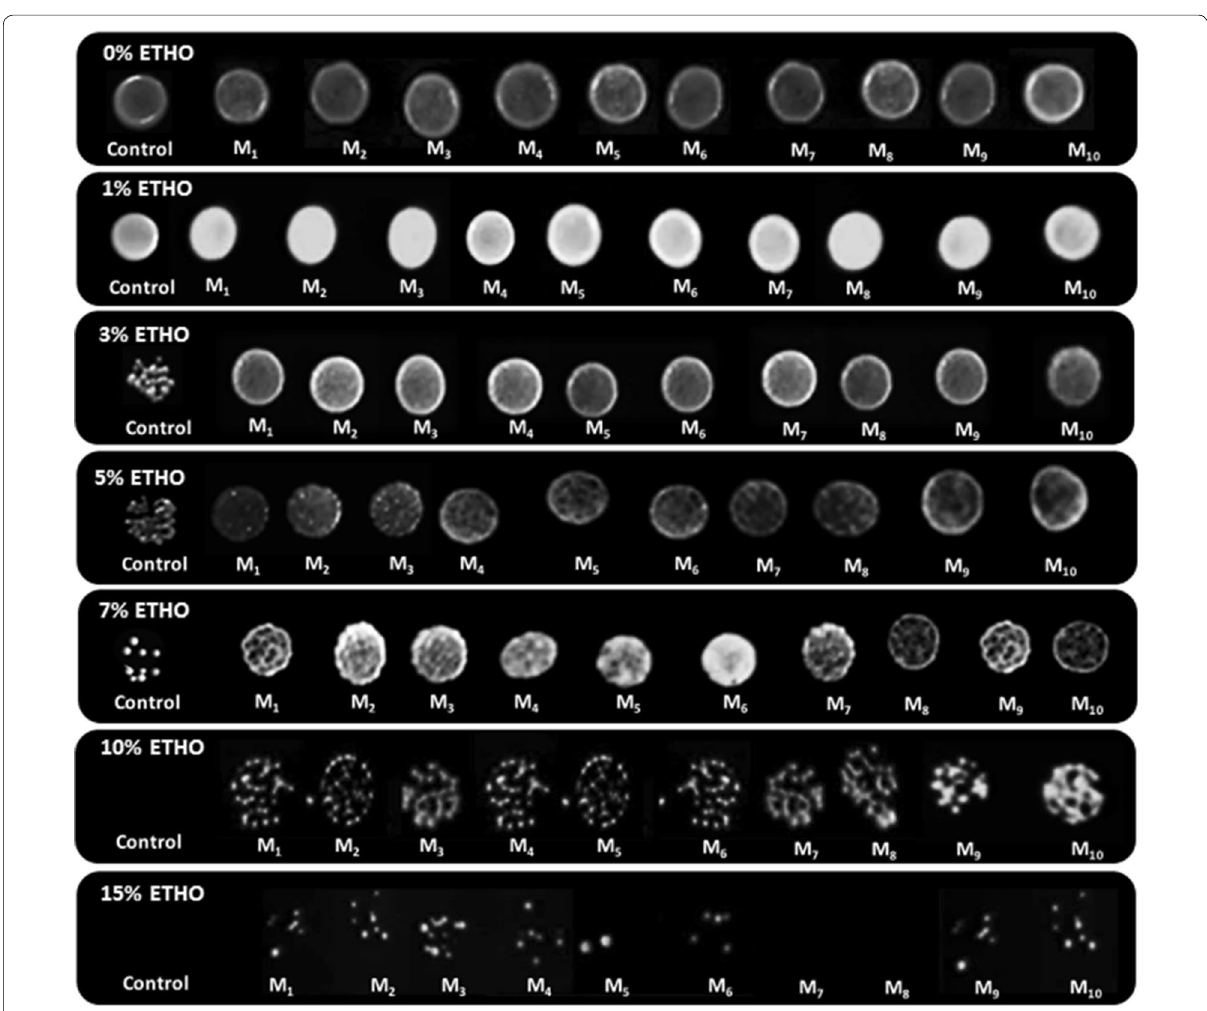
Fig. 3 Susceptibility of ethanol tolerance of S. cerevisiae mutant strains with various levels of ethanol concentrations (0, 1, 3, 5, 7, 10 and 15%) on YPD media containing Kan. M1, M2, M3, M4, M5, M6, M7, M8, M9 and M10 refer to the numbering of mutations colonies; as follows: R‑M20C1‑P3, R‑M16C4‑P3, R‑M4C1‑P3, R‑M12C4‑P3, R‑M18C4‑P3, R‑M5C1‑P3, R‑M3C49‑P10, R‑M18C5‑P10, R‑M17C4‑P20 and R‑M9C2‑P20,